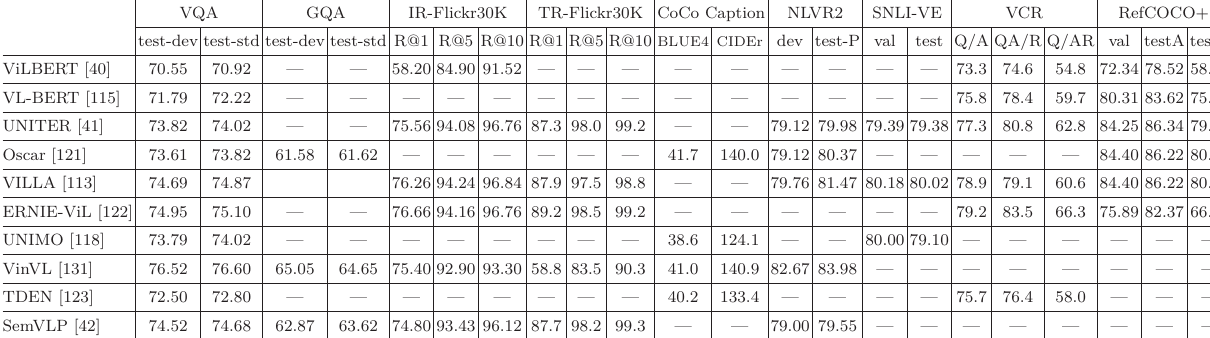
Table 6 Comparison of transformer-based V+L models on VQA [109], GQA [128], Flickr30K [112], CoCo Caption [111], NLVR2 [133], SNLI-VE [134], VCR [135], and RefCOCO+ [136] benchmarks VQA